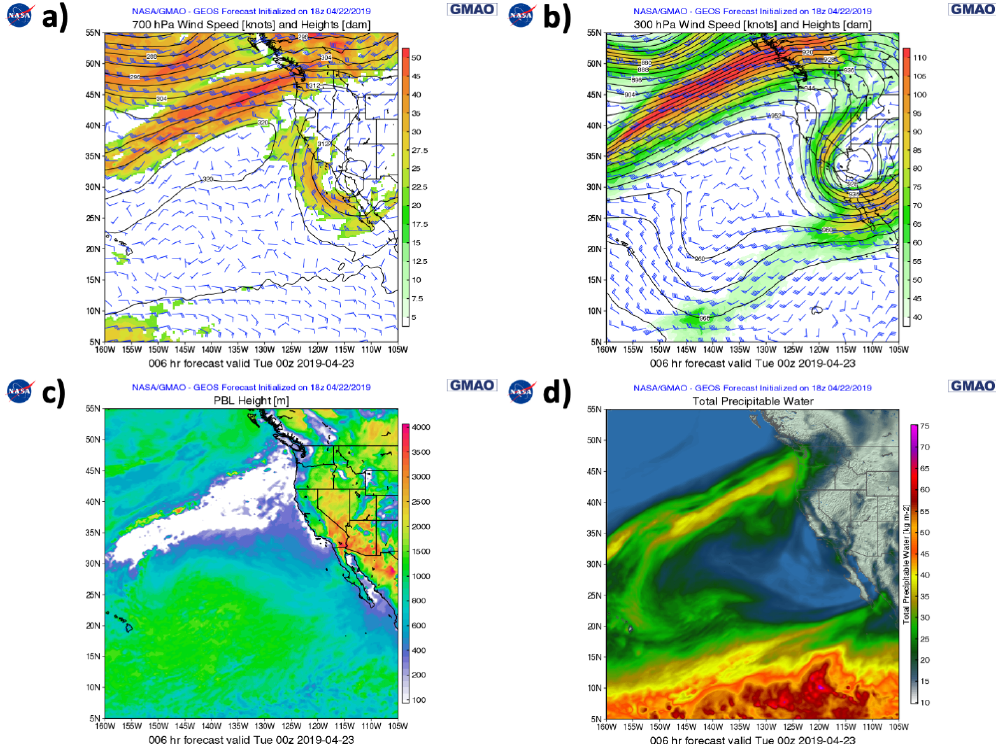
Figure 5. NASA GMAO GEOS-5 6h forecast of (a) 700hPa wind, (b) 300hPa wind, (c) PBL height, and (d) total precipitable water, valid at 00UTC on 23 April